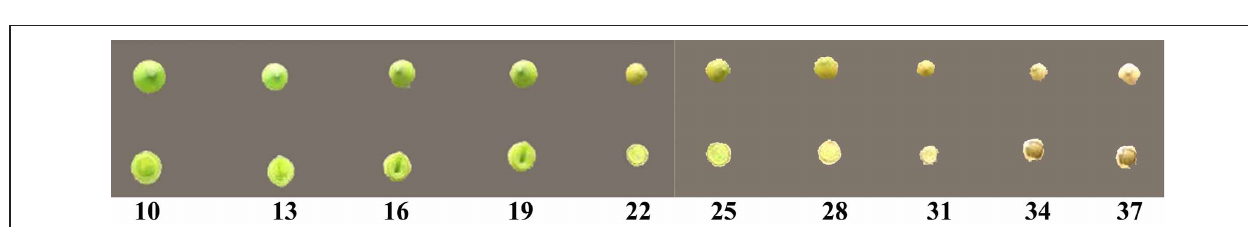
FIGURE 8 | Crambe seeds at different development stages. The upper panel is the whole seed and lower panel is the cross section of the seeds, but the whole seed with half silique removed at the last two stages. Figures represent days after flowering.